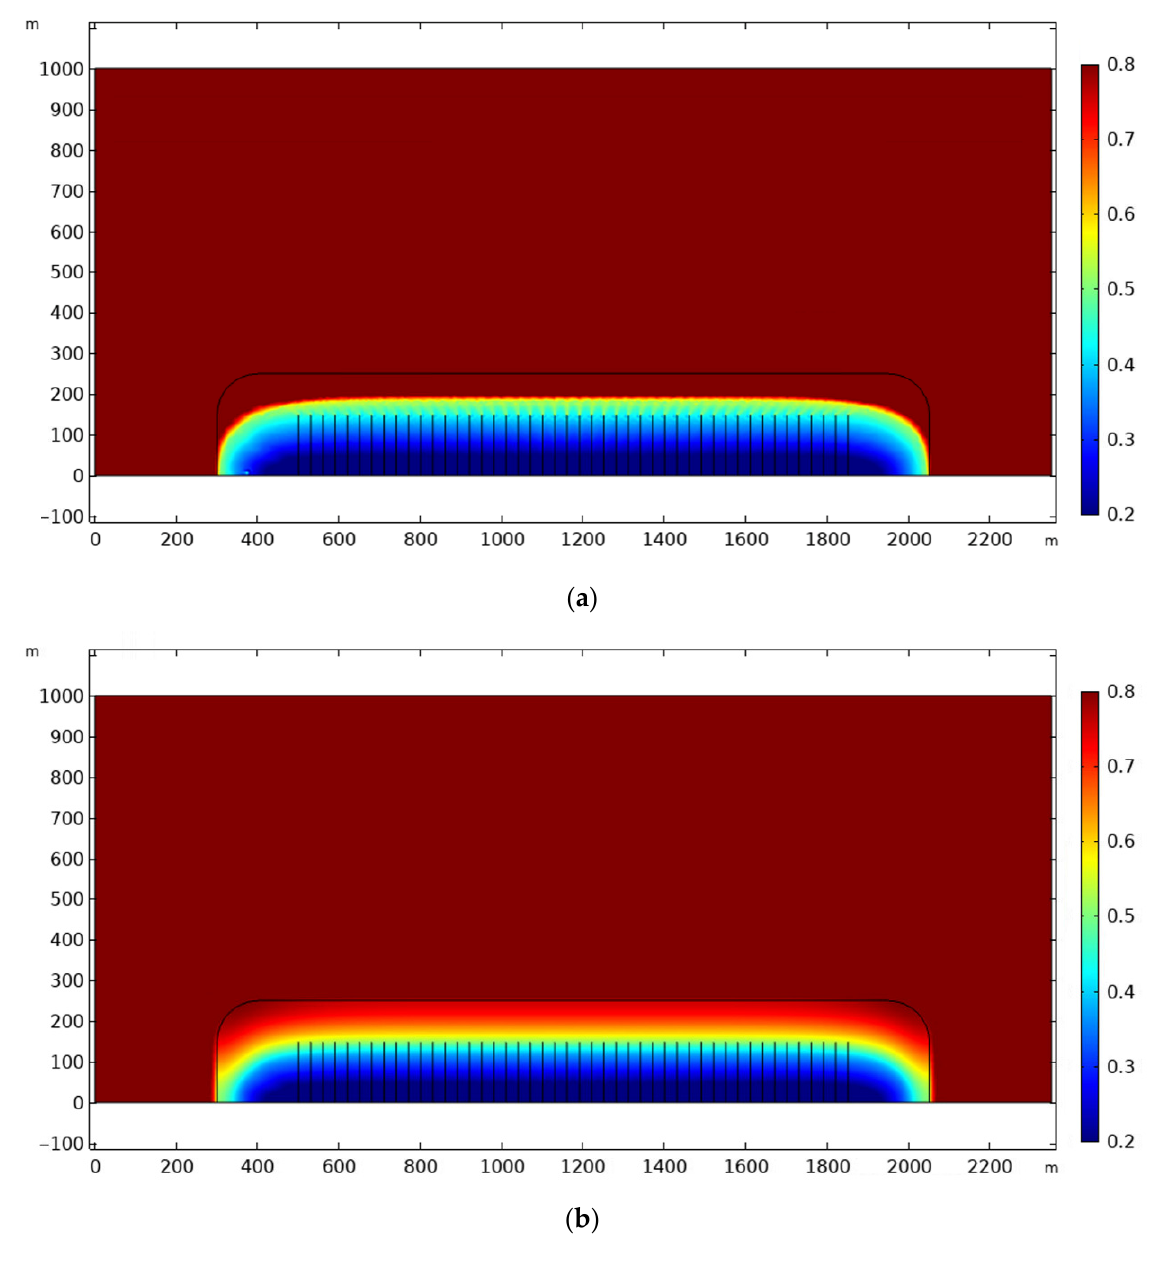
Figure 6. The comparison of oil saturation distribution before and after well shut-in operation. ( a ) Oil saturation distribution on the first day of the well shut-in operation. ( b ) Oil saturation distribution after 60th days of well shut-in operation.